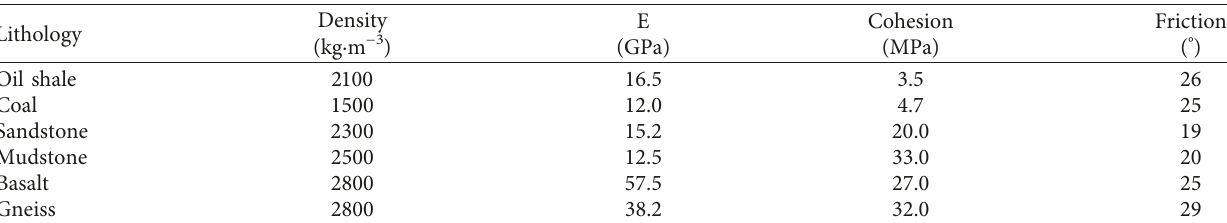
Table 4: Mechanical parameters of the slope